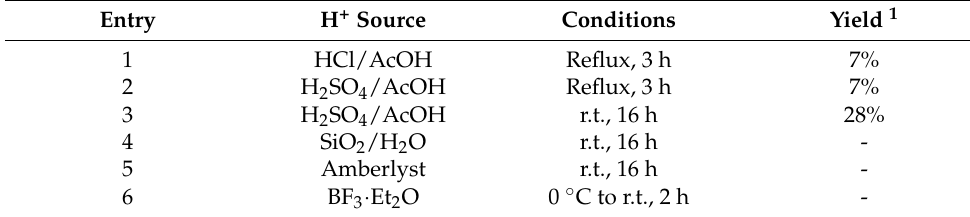
Table 1. Cyclization conditions for the synthesis of 2a .